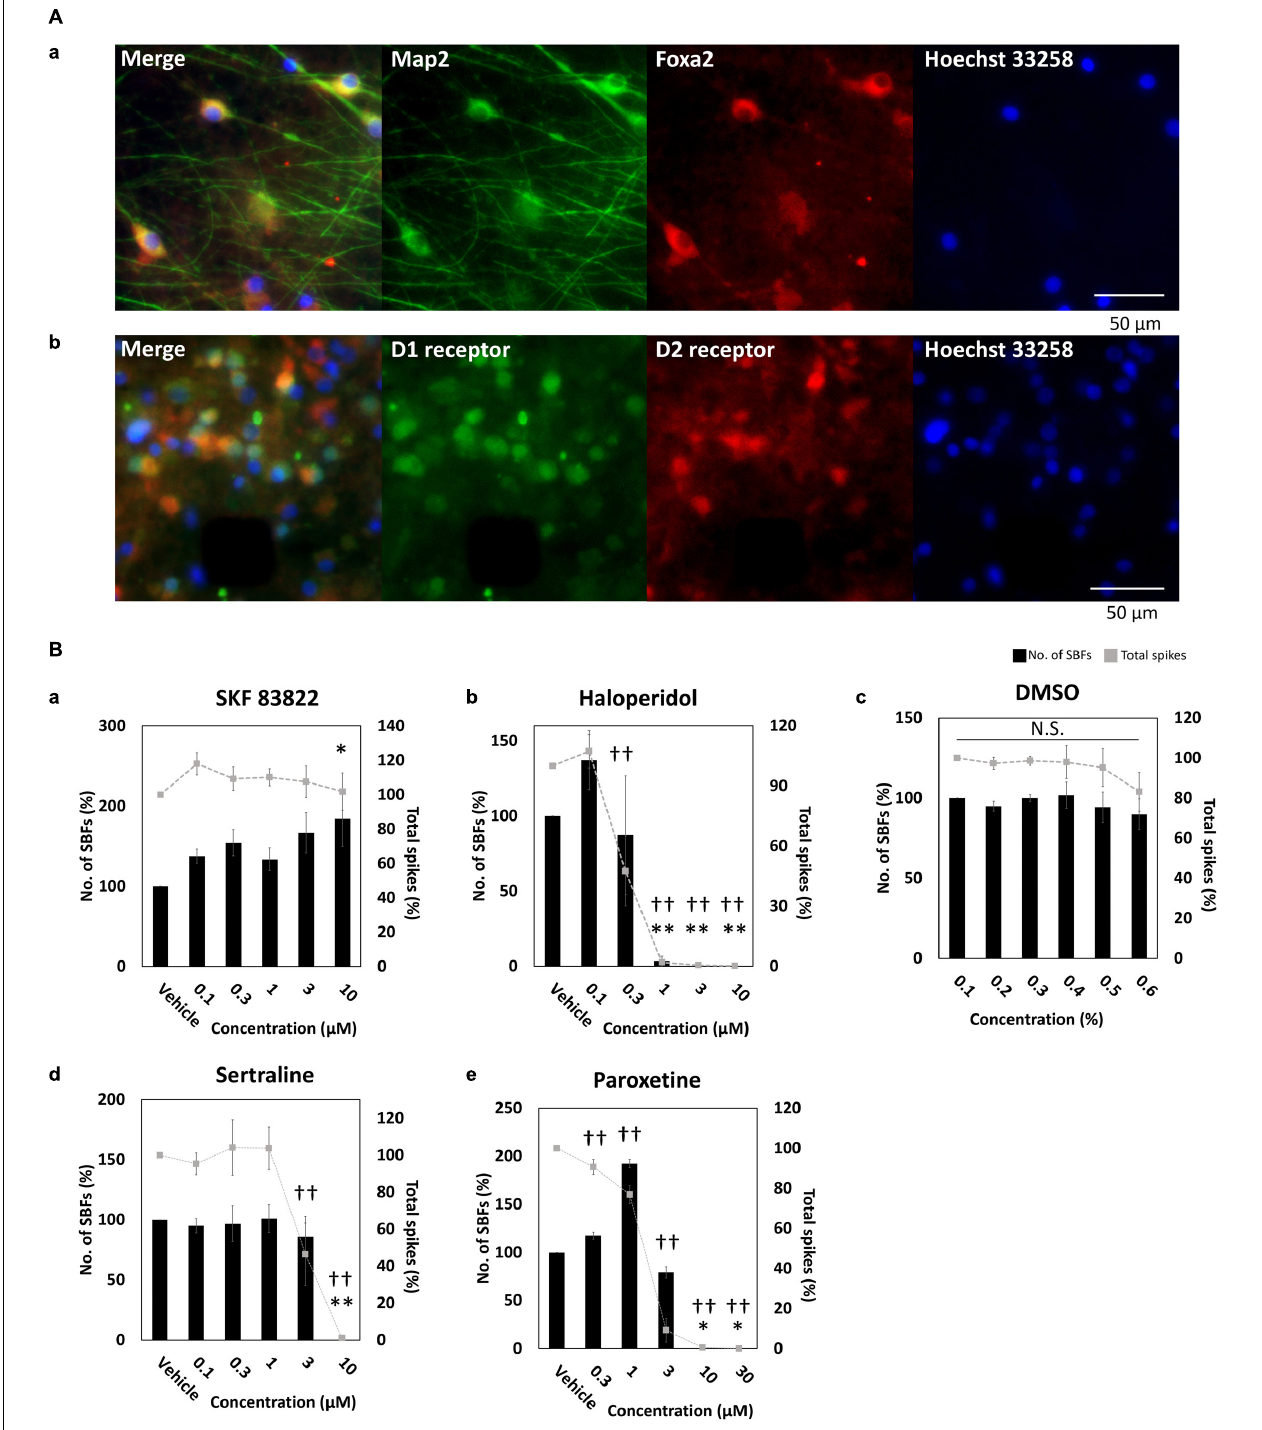
FIGURE 2 | Characterization of dopaminergic neuron. (A) Immunofluorescent image of FOXA2, and D 1 and D 2 receptors in cultured iCell DopaNeurons at 23 WIV. (a) FOXA2 expression. MAP2 (green), FOXA2 (red), Hoechst 33258 (blue). Scale bars = 50 µ m. (b) Dopamine receptor expression. D 1 receptor (green), D 2 receptor (red), Hoechst 33258 (blue). Scale bars = 50 µ m. (B) The change of SBFs and spikes in SKF83822, haloperidol, DMSO, sertraline, and paroxetine administration. Spontaneous activity for 10 min was measured for each concentration. Black bars indicate SBFs and gray dashed lines indicate spikes. Data were analyzed using one-way ANOVA followed by post hoc Dunnett’s test [ ∗ p < 0.05, ∗∗ p < 0.01 vs. vehicle (SBFs), † p < 0.05, †† p < 0.01 vs. vehicle (total spikes)]. (a) SKF 83822 ( n = 6 wells). (b) Haloperidol ( n = 5). (c) DMSO ( n = 6). (d) Sertraline ( n = 6). (e) Paroxetine ( n = 6).